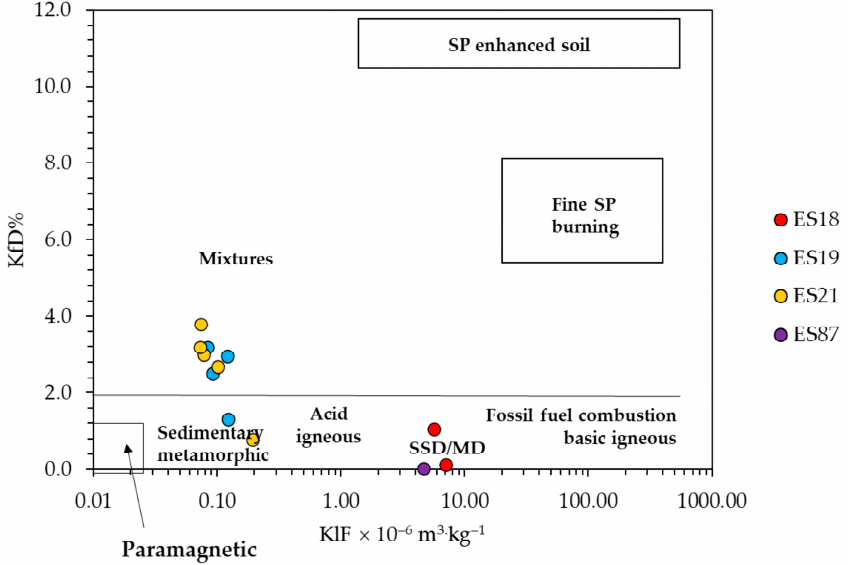
Figure 10. A schematic KfD% scattergram showing typical positions of samples dominated by various domains and sources.